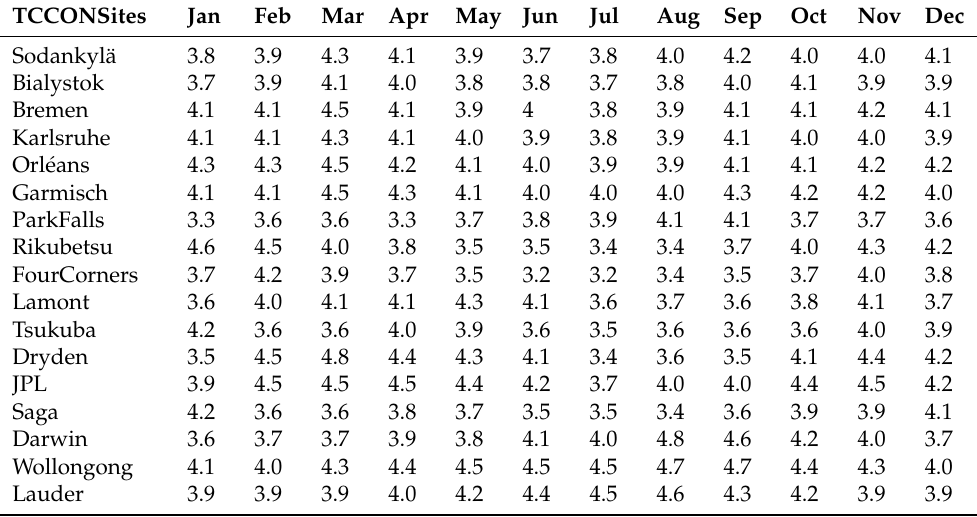
Table A2. Rates of change of integrated water vapor (IWV) with respect to height (% per 100 m) for each TCCON